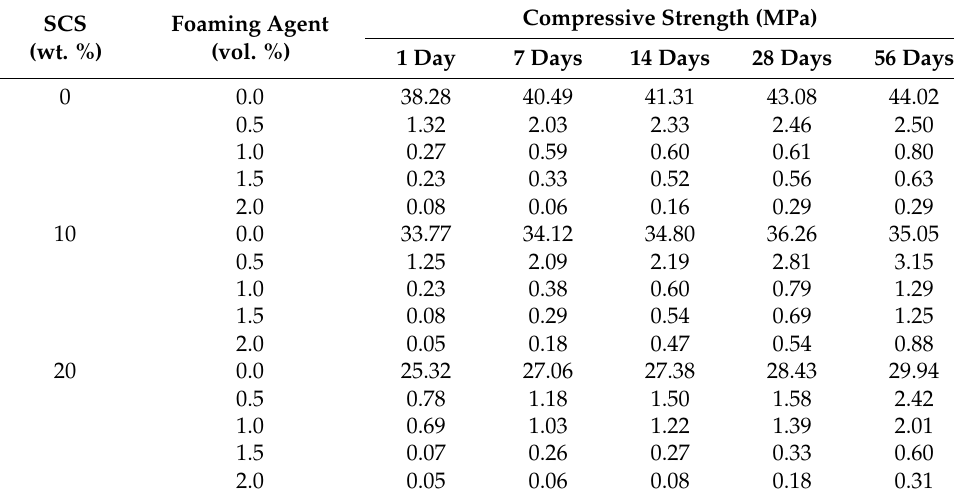
Table 2. Compressive strength development of lightweight FGPs.